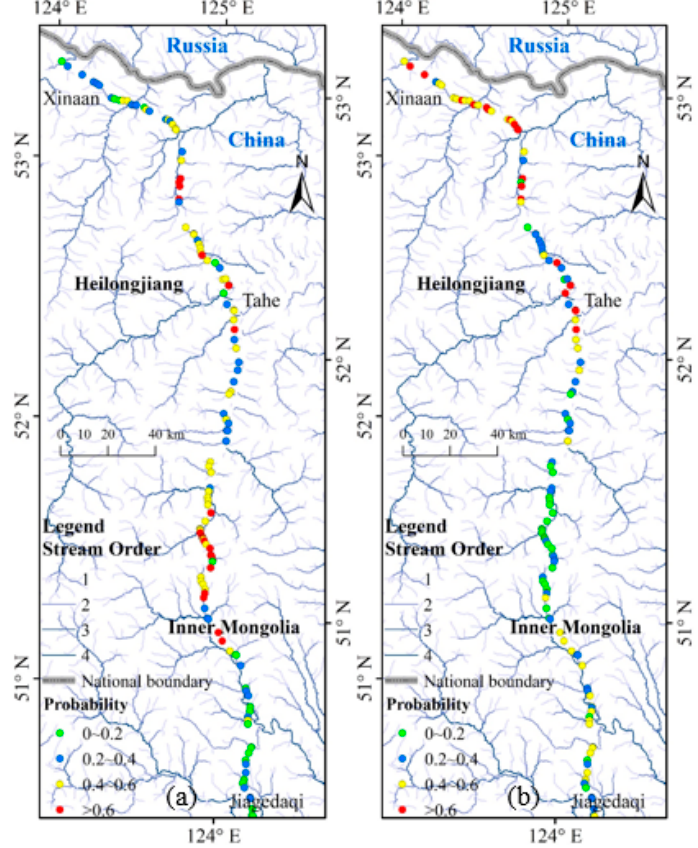
Figure 9. Risk assessment of frost heave and thawing settlement (a) and water erosion by surface flows (b) along the CRCOP.